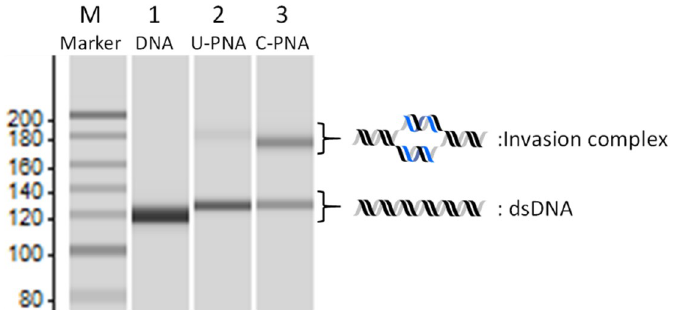
Figure 2. Comparison of U-PNA and C-PNA invasion efficiency in the presence of 75 mM NaCl. M: 20-bp DNA Ladder (TaKaRa); lane 1: 130-bp DNA only; lane2 U-PNA; lane 3: C-PNA. Invasion conditions: [DNA] = [each PNA] = 50 nM, [HEPES (pH 7.0)] = 5 mM, and [NaCl] = 75 mM at 50 ◦ C for 1